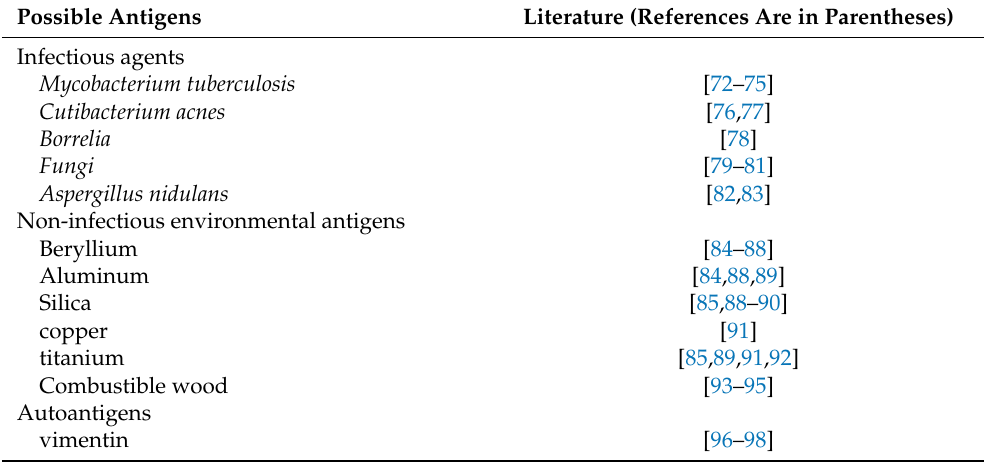
Table 1. Regarding infectious agents, most studies were performed addressing the possible role of either mycobacteria , aspergillus species or C. acnes as antigens in sarcoidosis [71]. Table 1. Possible antigens in